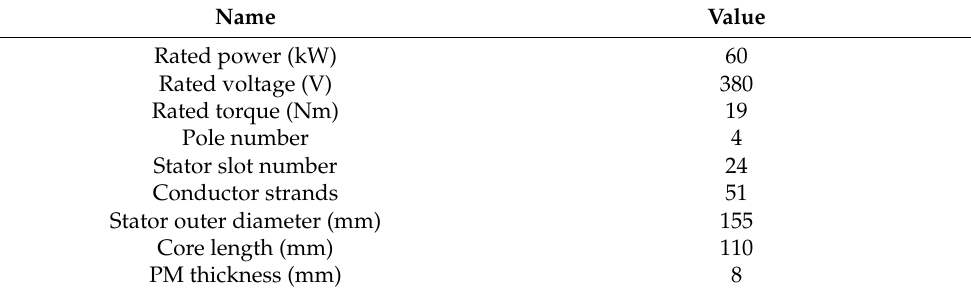
Table 1. Some key design parameters of the HSPMM.